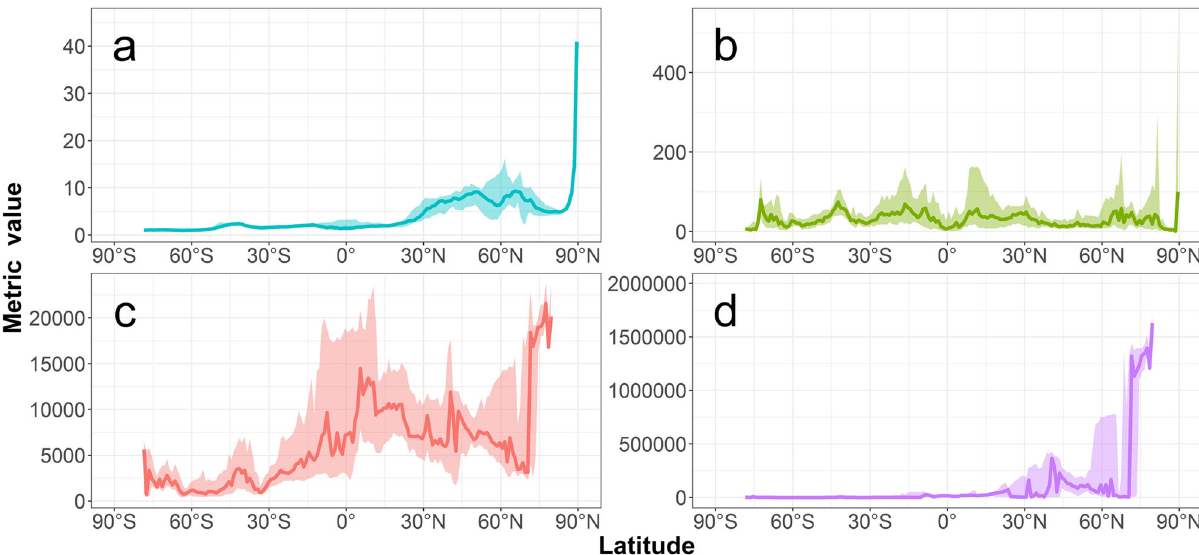
Fig. 3 Median connectivity metric value across a latitudinal gradient. The median value for current fl ow a , path density b , minimum exposure distance c , and minimum cumulative exposure d was calculated for 1° moving windows (solid line). The shaded area corresponds to 25% and 75% quantiles of the metric values per latitudinal point.